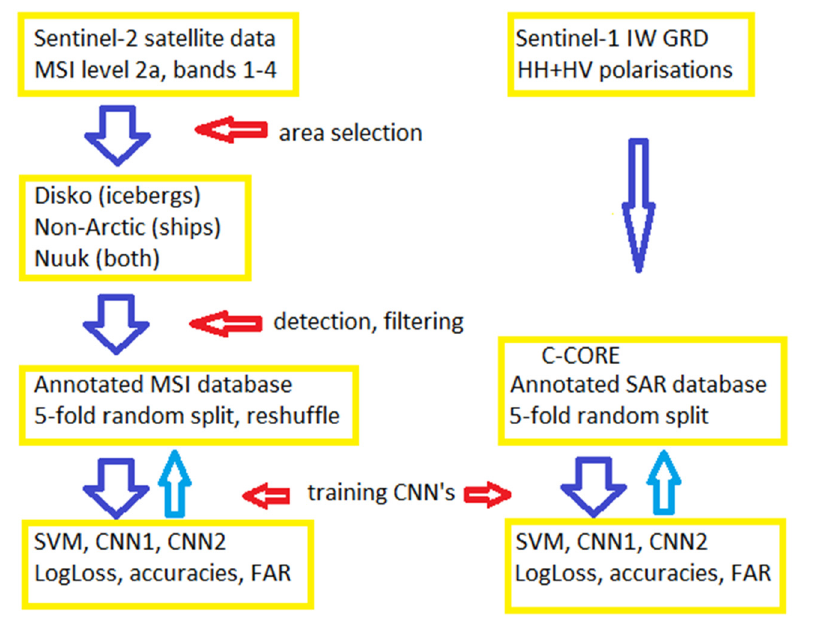
Figure 3. Flowchart: data selection, ship and iceberg image detection for building an annotated dataset, the subsequent training of convolutional neural networks producing results for log-loss and accuracies.